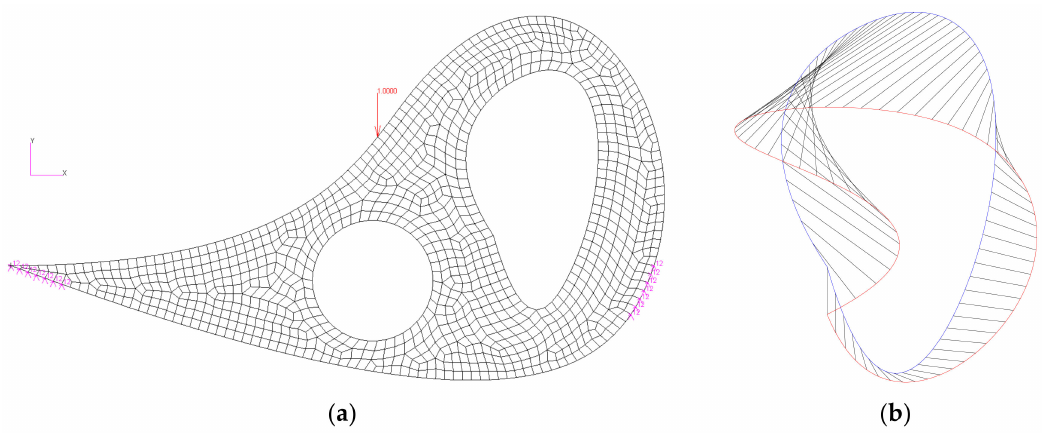
Figure 19. ( a ) Discretization and constraints in FEM of varied bubbles, ( b ) mesh between varied